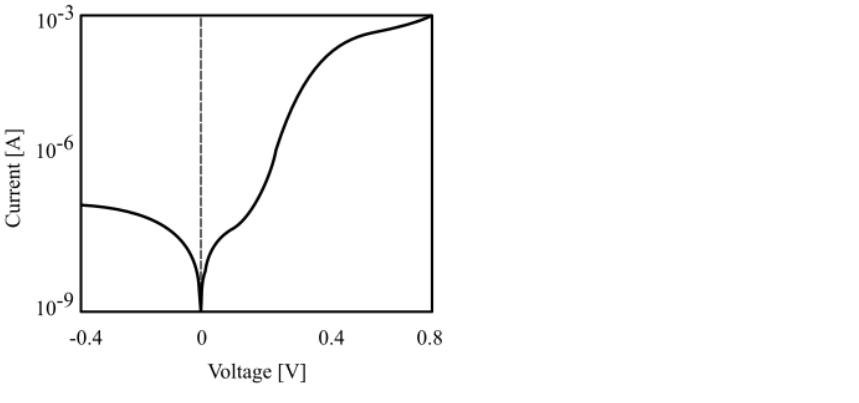
Figure 15. Dark I–V curve of a solar cell. Source [45], own elaboration.